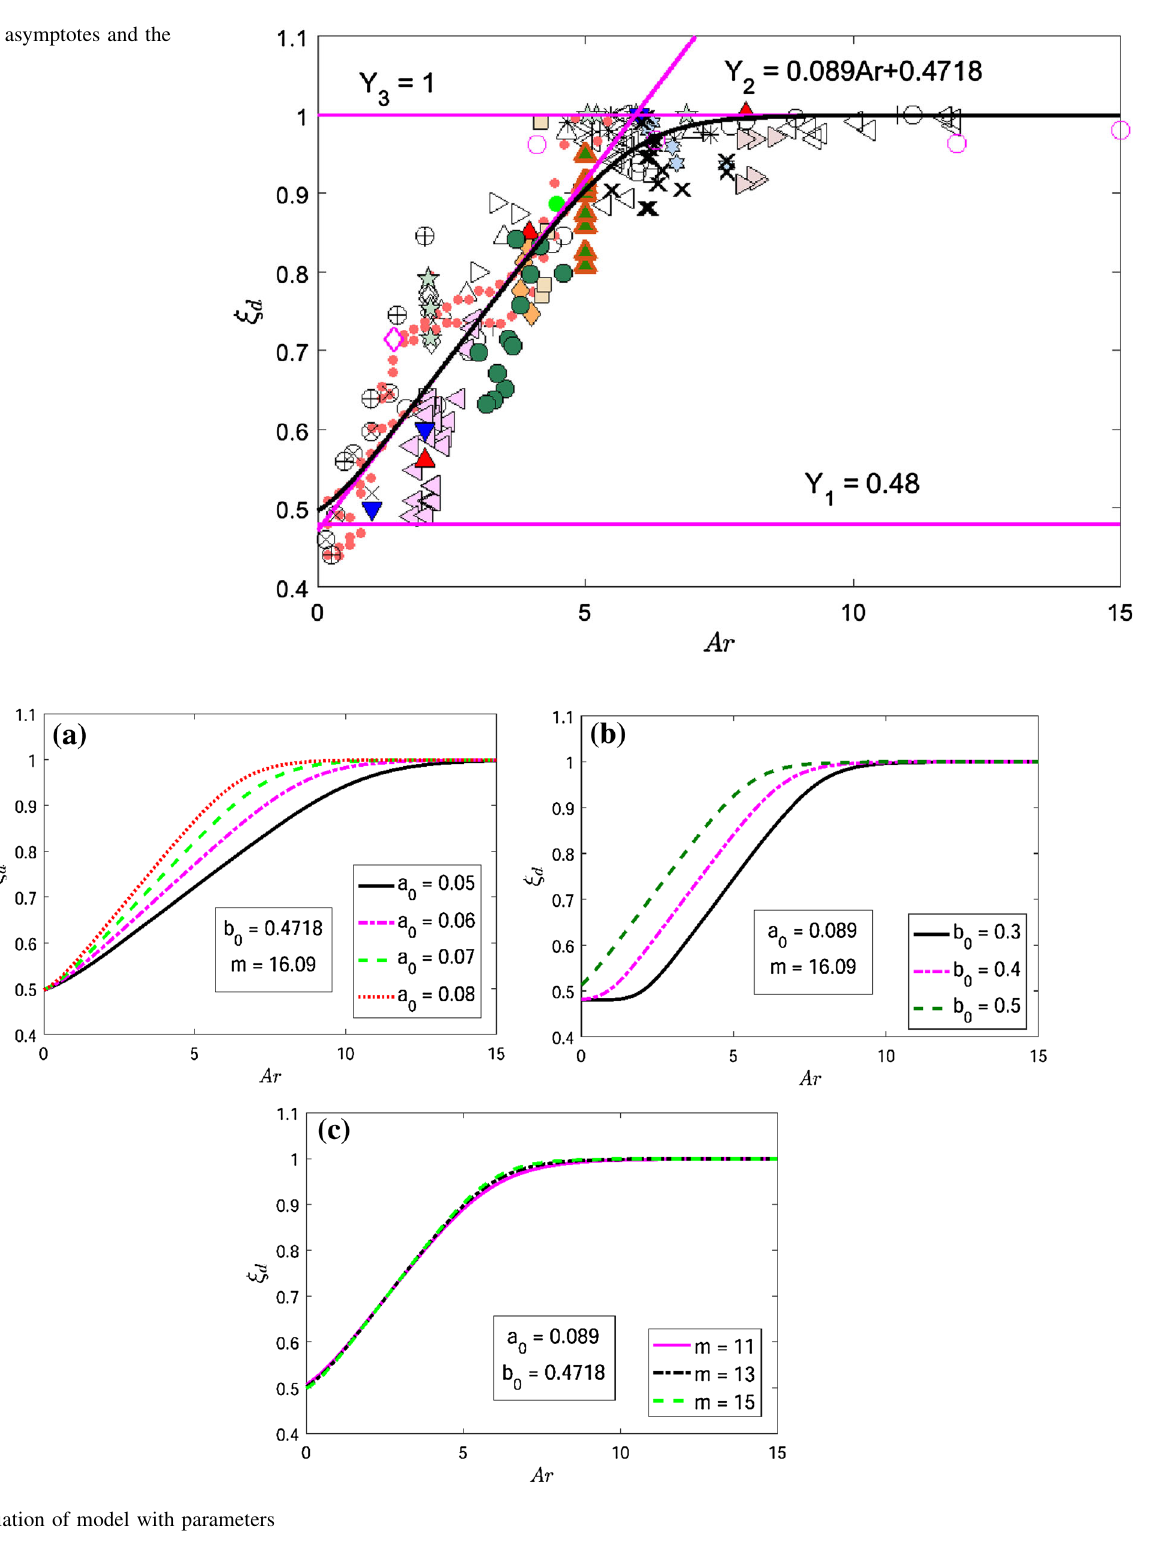
Fig. 3a the variation with a 0 for four different values of it are shown. Similarly in Fig. 3b and in Fig. 3c the variation for three different values of b 0 and m are shown